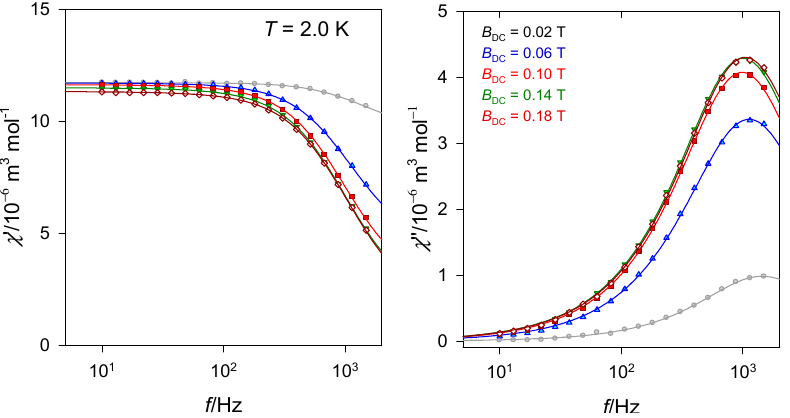
Figure 5. Frequency dependence of the AC susceptibility for 1 for a set of external fields at T = 2.0 K.